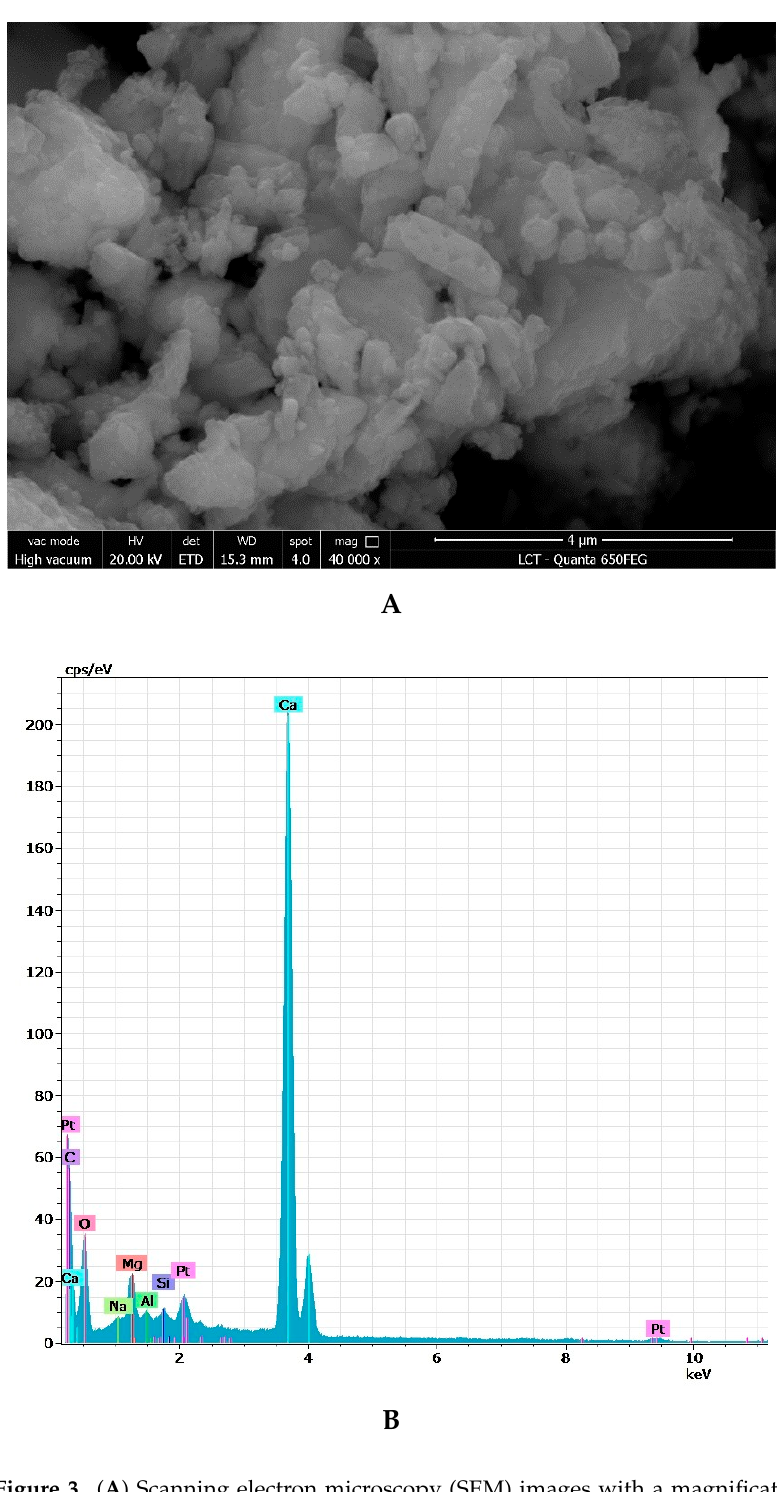
Figure 3. ( A ) Scanning electron microscopy (SEM) images with a magnification of 40,000× that demonstrated xenomorphic crystals for the L. calcareum CaCO 3 . ( B ) Energy-dispersive spectroscopy (EDS) analysis: from the information contained in the EDS spectrum it is possible to obtain quan- titative information on the sample composition on a microscopic scale. In the spectrum, Platinum (Pt), Carbon (C), Oxygen (O), Sodium (Na), Magnesium (Mg), Aluminium (Al) and Silicon (Si) were identified, in addition to Calcium